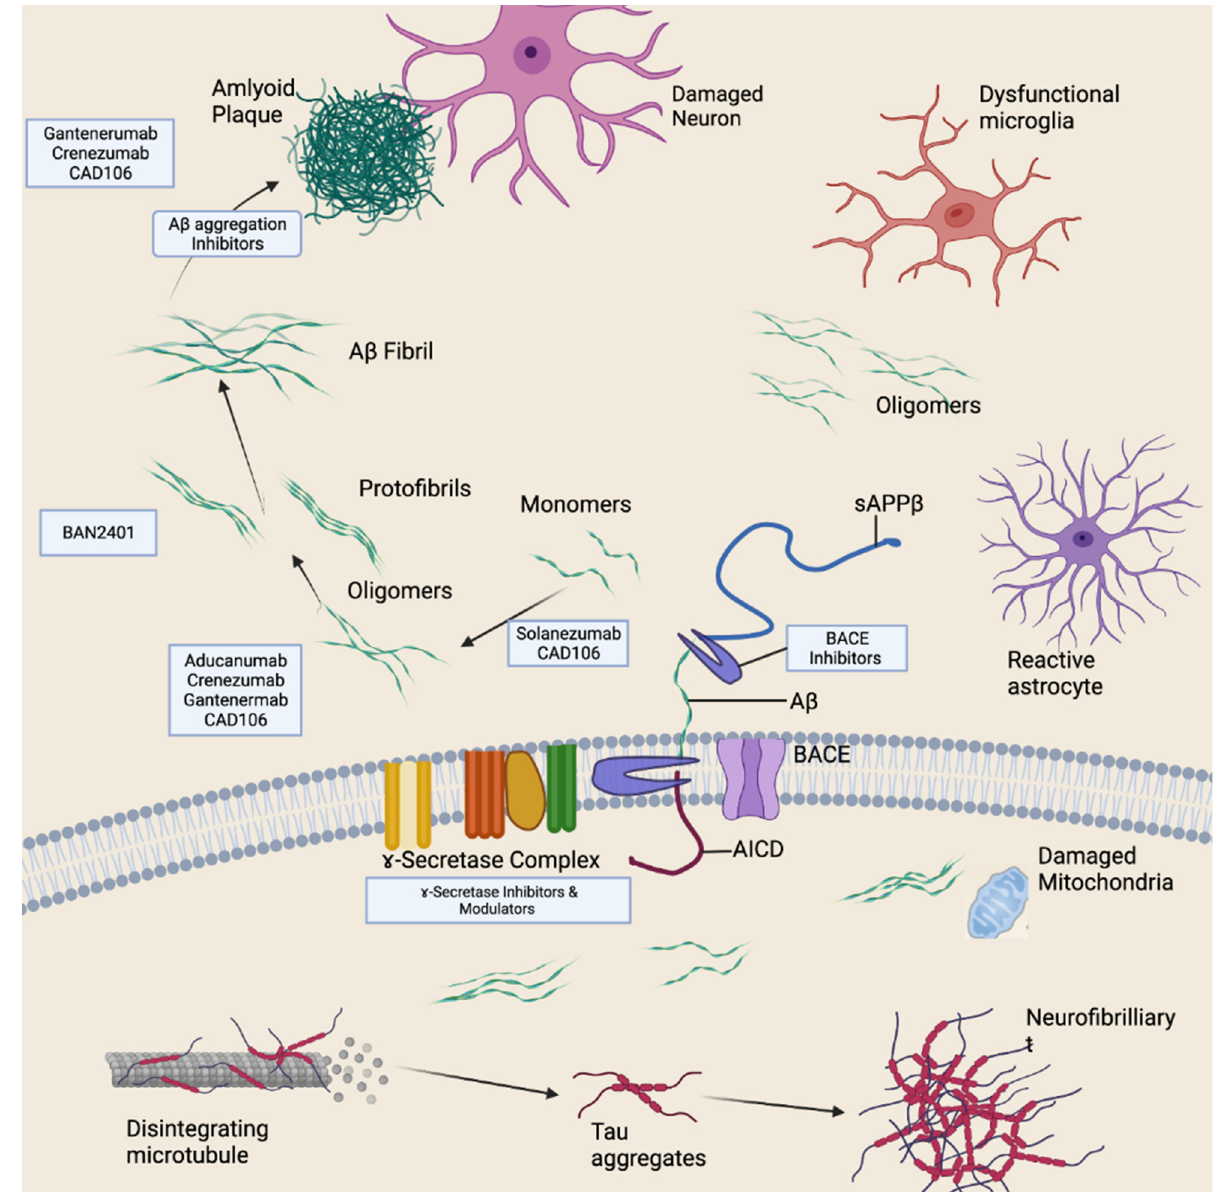
Figure 4. Anti-amyloid-beta therapeutics . Therapeutic strategies target different forms of amyloid beta to varying stages of its processing.